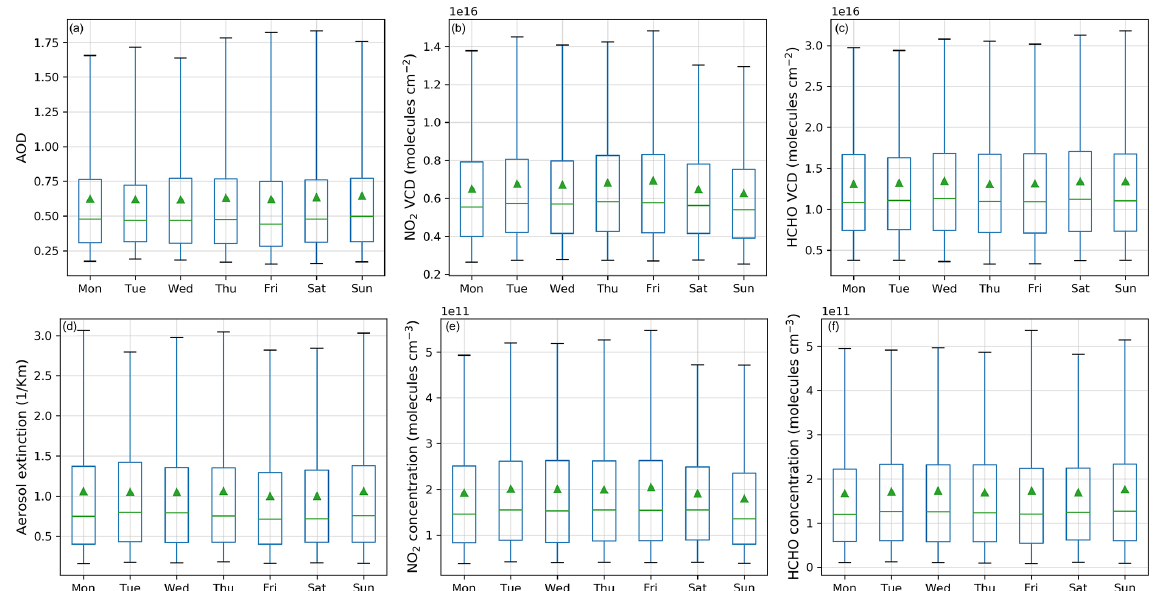
Figure F6. Mean weekly variation in (a) AOD, (b) NO 2 VCD, and (c) HCHO VCD. The bottom row shows the mean weekly variation in (d) aerosol extinction, (e) NO 2 concentration, and (f) HCHO concentration in the bottom-most layer (0–200m) retrieved from the profile inversion of the MAX-DOAS